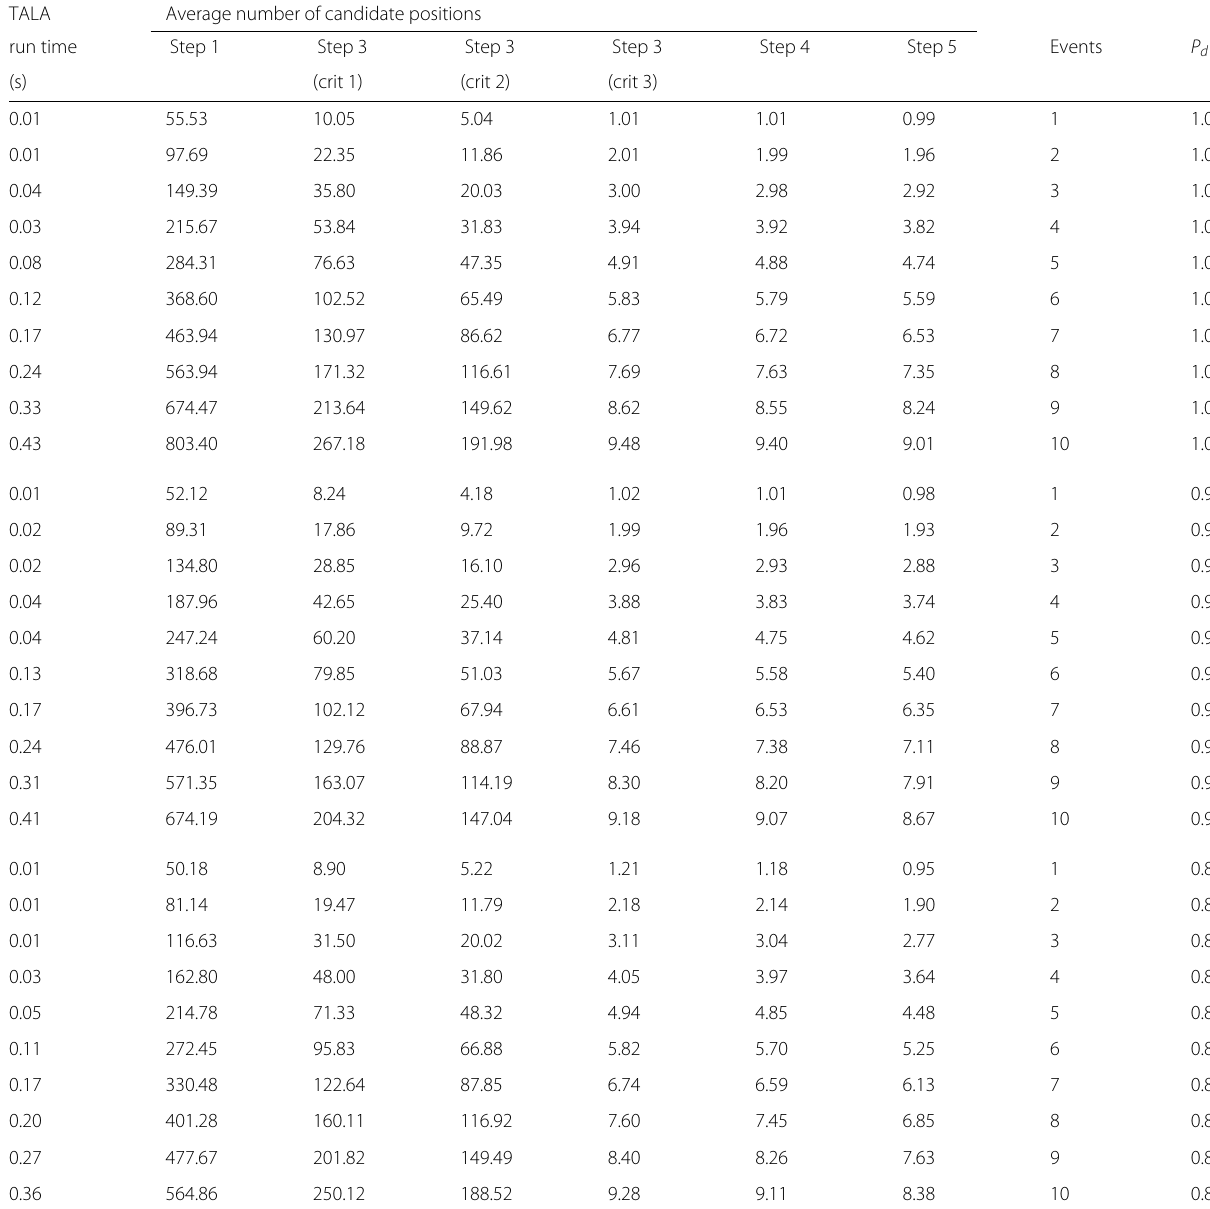
Table 8 TALA average computational time, and the average number of candidate locations at the end of each step of the TALA, for scenario